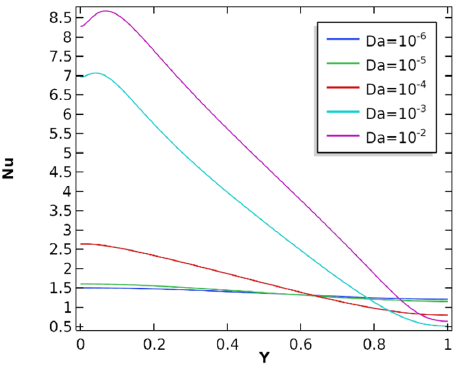
Figure 10. Variation in local Nu and Sh . Table 5. Average Nu and Sh comparison.